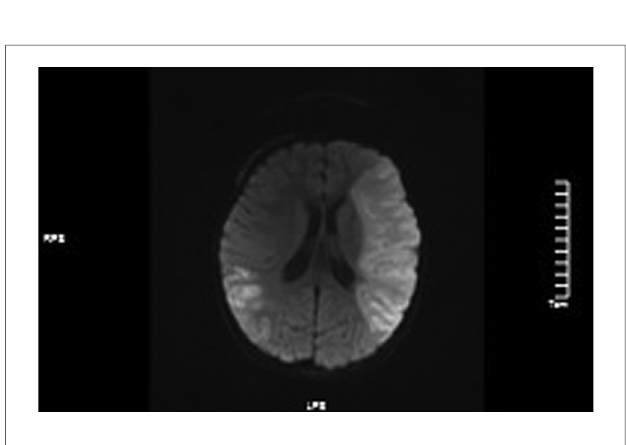
FIGURE 6 DWI images showed high signals in the left frontotem poral lobe and the right temporal.